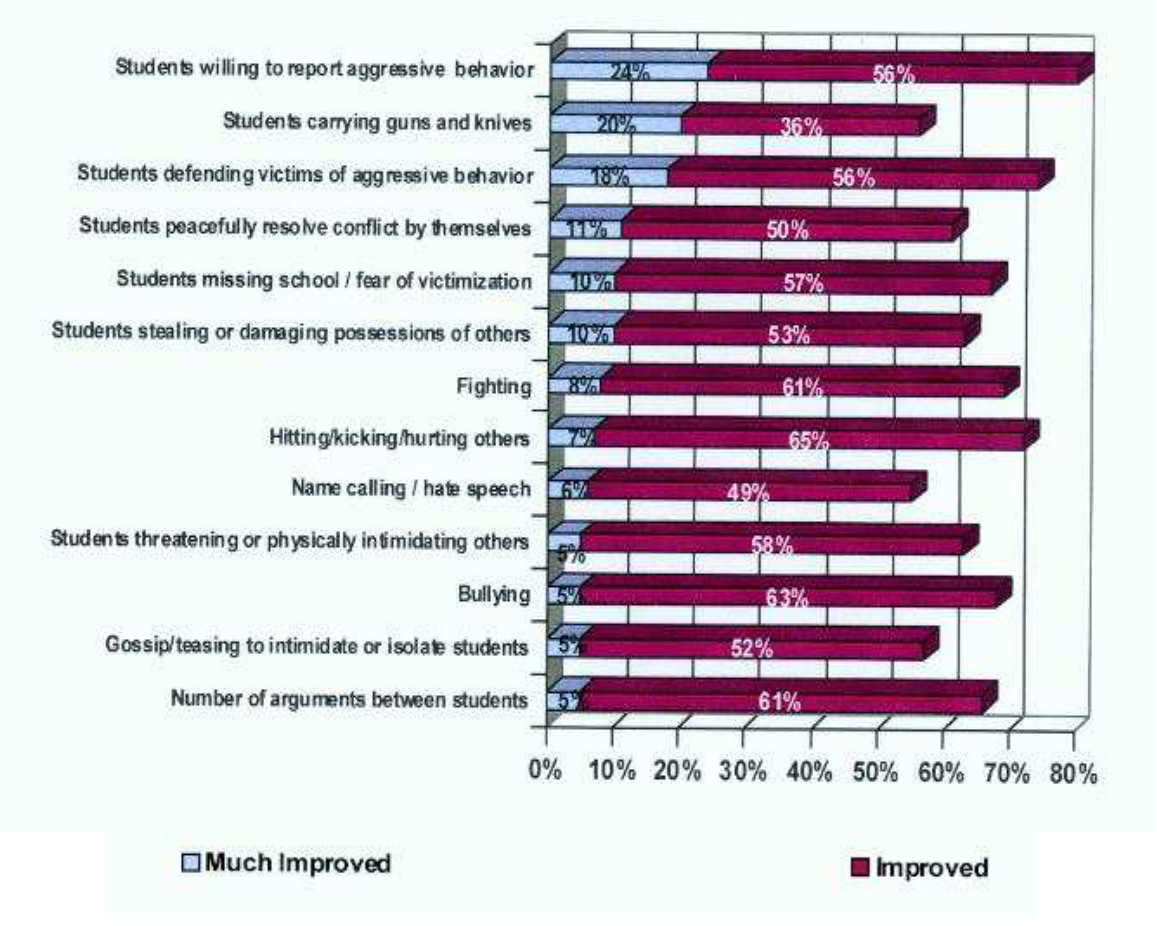
Teacher Ratings of Changes Due to Kids Win Program